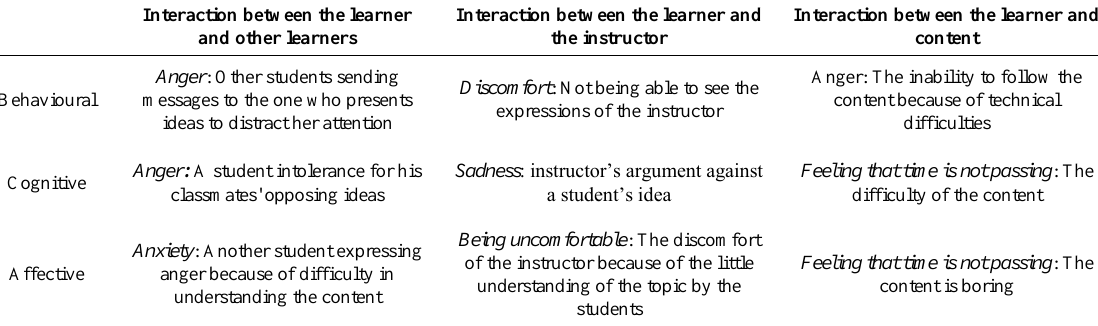
Table 4. Occurrences in the synchronous lectures that resulted in negative affective